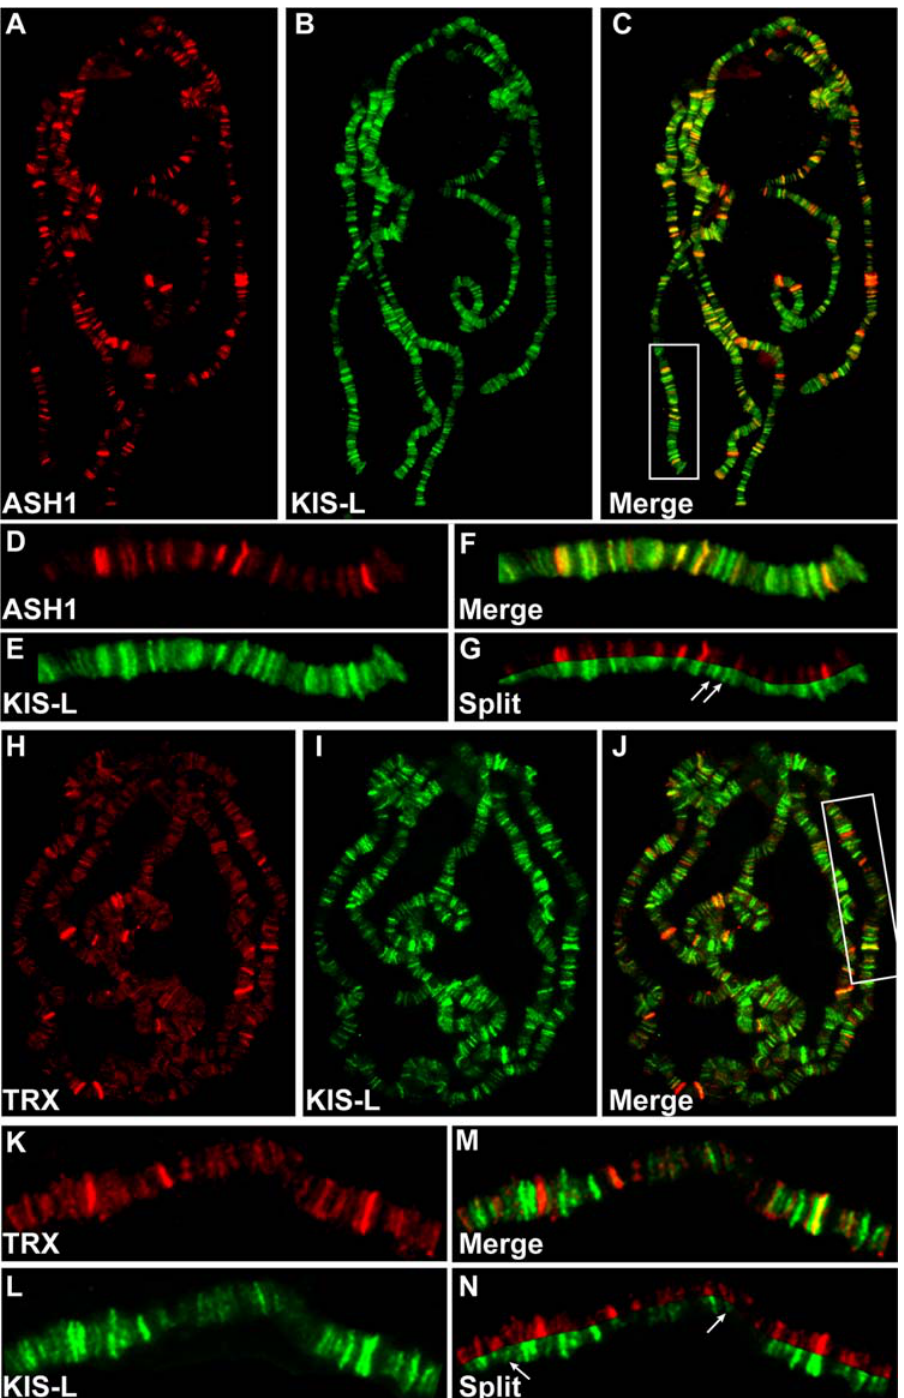
Figure 2. KIS-L co-localizes with the trithorax group proteins ASH1 and TRX on polytene chromosomes. A–C) The distributions of ASH1 (A, red) and KIS-L (B, green) on wild-type polytene chromosomes are shown together with the merged image (C). D–G: Magnification of the chromosome arm bounded by the white rectangle in C is shown. Arrows in G mark examples of KIS-L bands that do not overlap with ASH1. H–J) The distributions of TRX (H, red), KIS-L (I, green) and the merged image (J) are shown. K–N: represent the magnification of the chromosome arm bound by the white rectangle in J. The arrows in N represent bands of KIS-L that do not overlap with TRX.